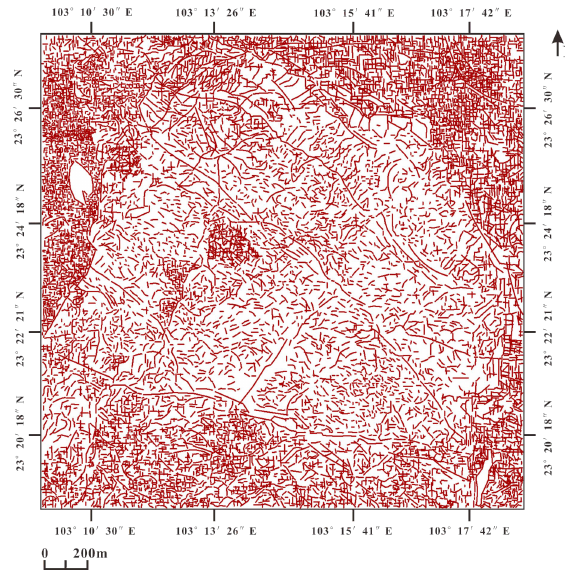
Figure 7. Image data after Gaussian low-pass filtering.